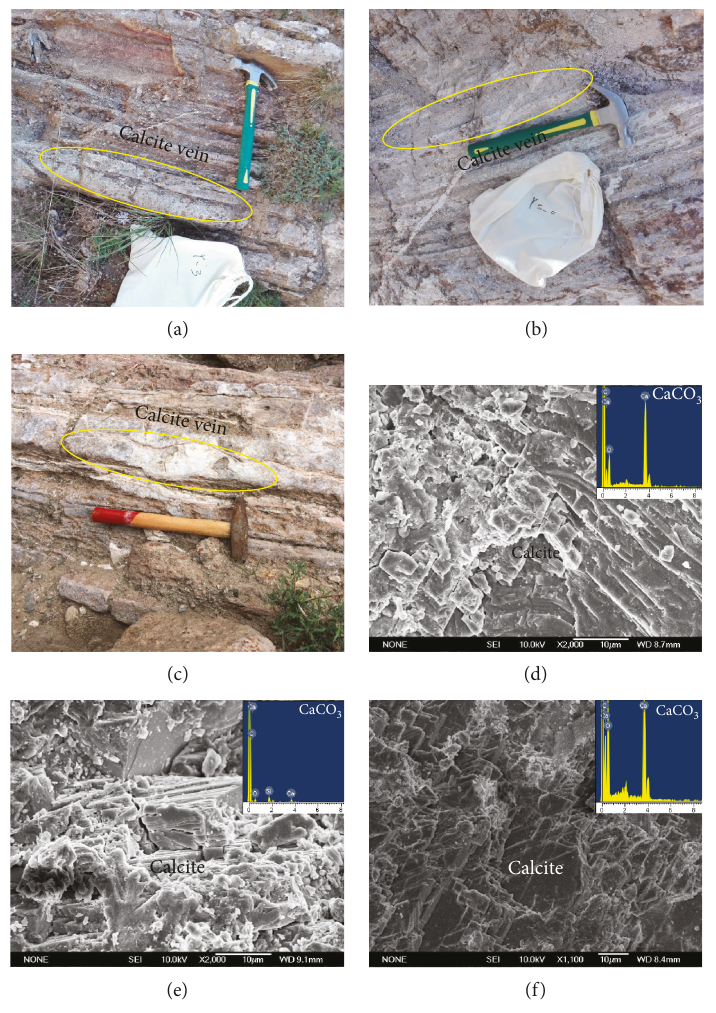
Figure 2: Photos and SEM images of three rock samples (Y-3, Y-4, and Y-5) collected from the calcite veins in the discharge area of Zhacang geothermal fi eld. Table 2: Mineralogical compositions (wt%) in calcite veins detected by X-ray di ff